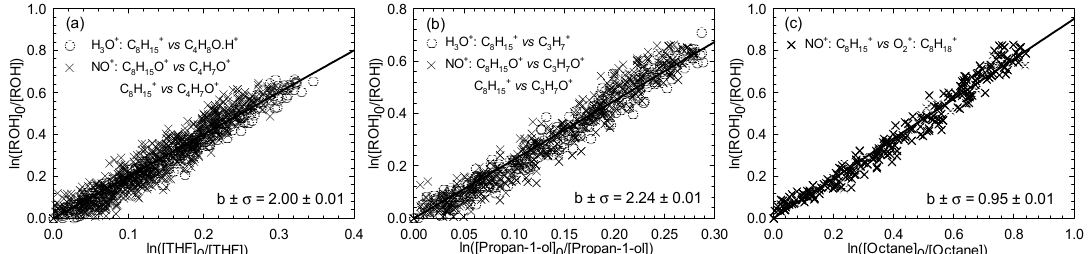
Figure 5. Relative loss of 1-octen-3-ol vs. that of THF ( a ), propan-1-ol ( b ), and octane ( c ) in the Cl atom-initiated reaction.